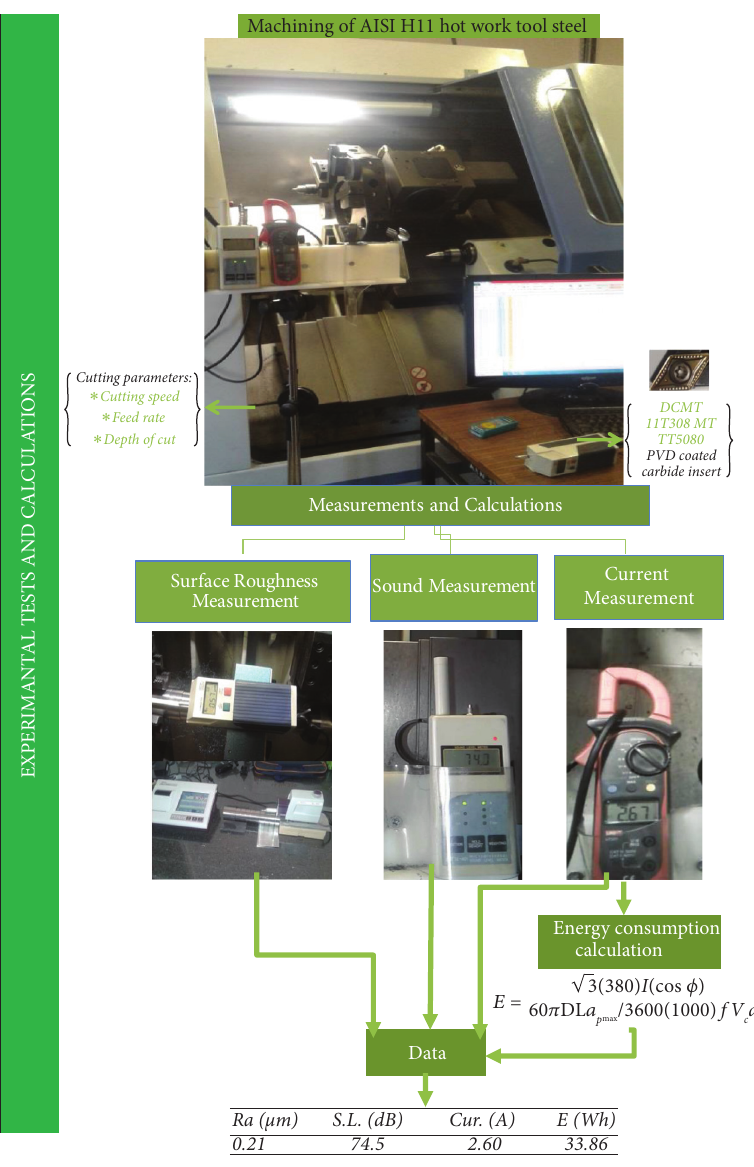
Figure 2: Experimental